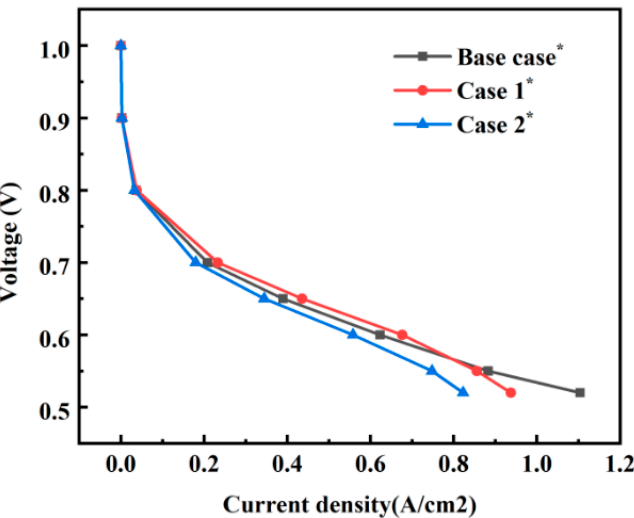
Figure 9. Comparison of the polarization curves for the Base case*, Case 1* and Case 2*.